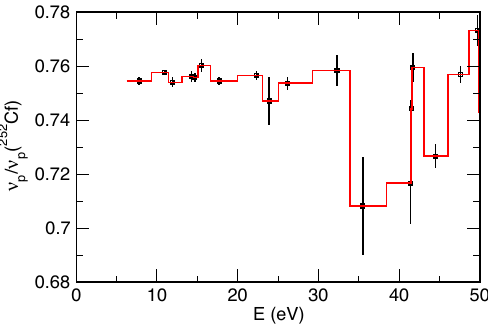
Figure 2. Comparison between the averaged and pointwise descriptions of the data from Fréhaut [6].